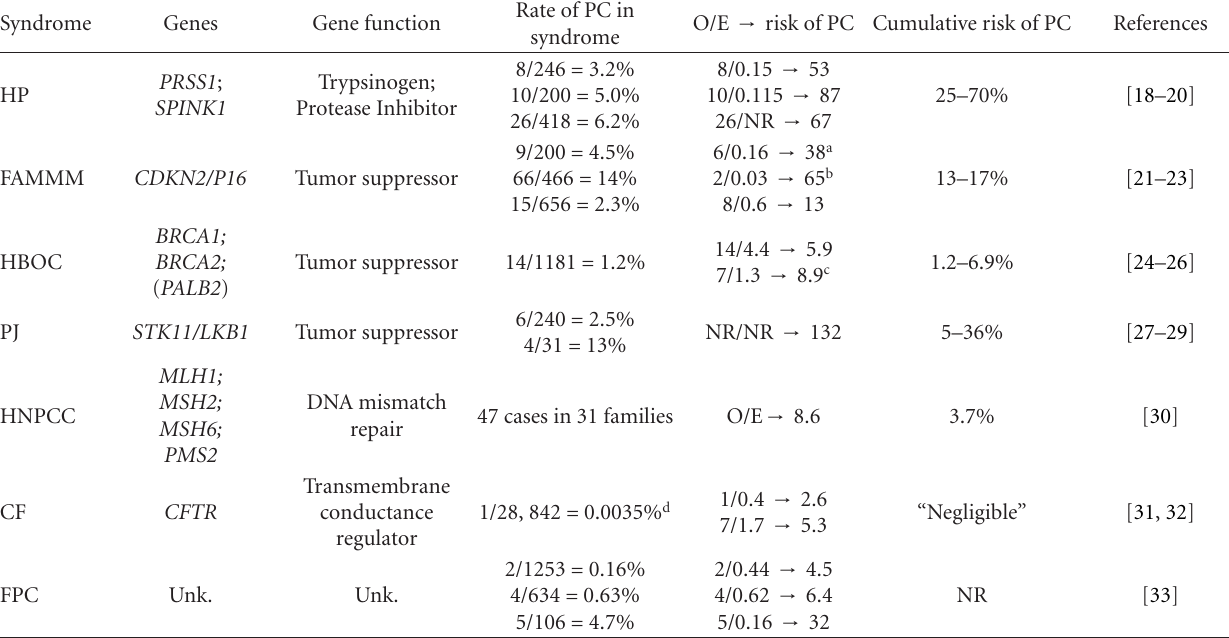
Table 2: Known inherited syndromes associated with increased risk of HPC.